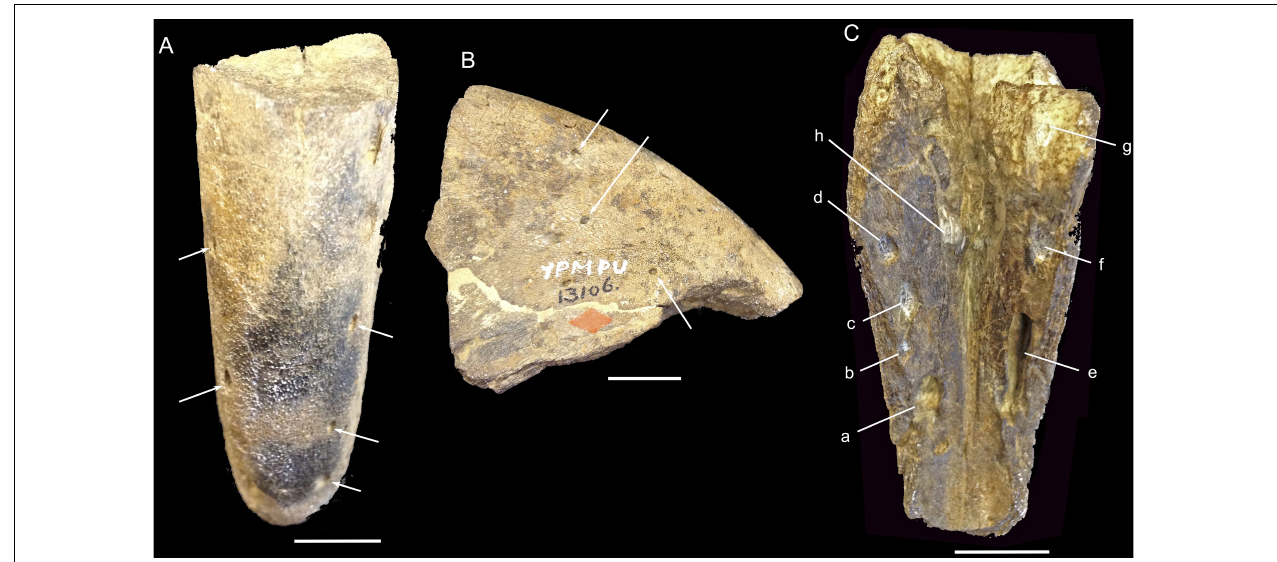
FIGURE 1 | External views of Omorhamphus storchii YPM 13106 (rostral part of juvenile premaxilla). (A) Dorsal view. (B) Right lateral view. (a–g) Large openings visible in ventral view (C) on lateral sides of the palate just medial to the eroded tomia (a–d, left side; e–g, right side; h, median-left). The ventral pits are obturated by sediment, except the large oblique pit (labeled e). Several medium-sized foramina are visible (white arrows) on the dorsal and lateral sides (A,B) . Scale bars, 10